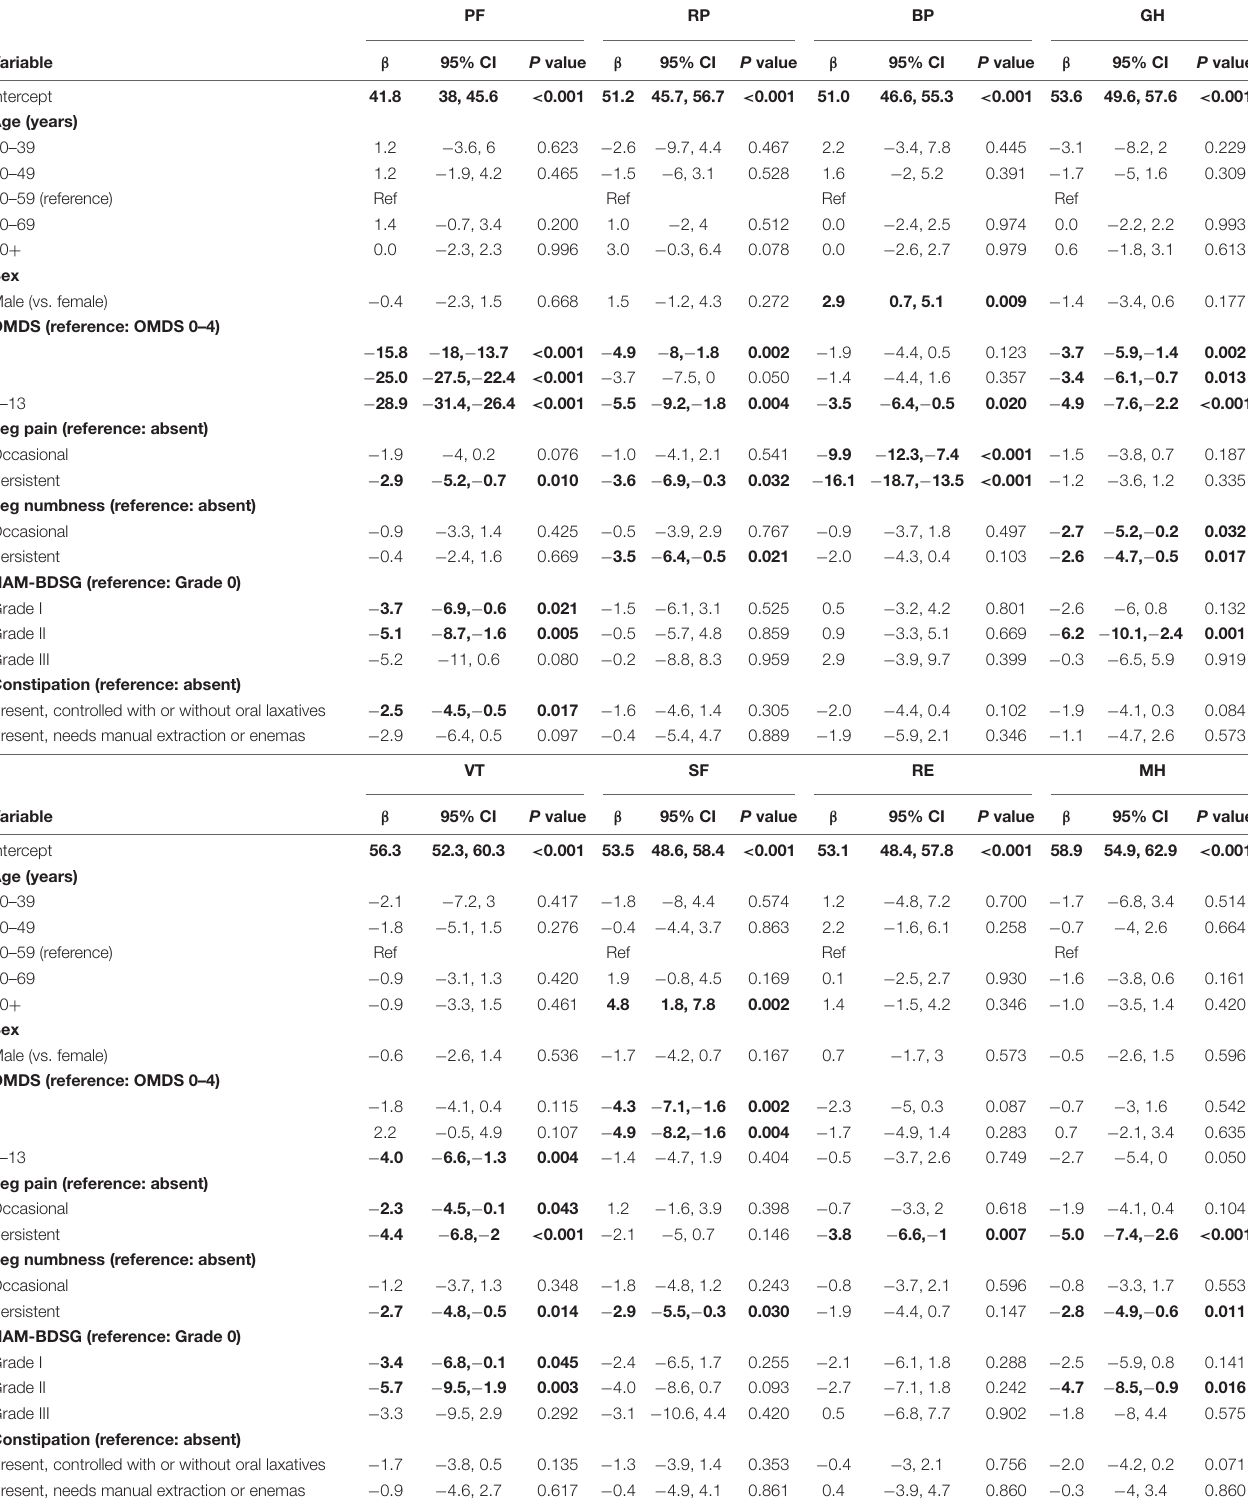
TABLE 4 | Association between SF-36 subscales and HAM-related